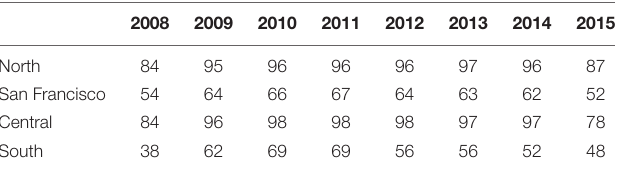
TABLE 1 | The percentage of traffic (i.e., the sum of the distance traveled per day in each grid cell) that occurs more than 24 nmi from the mainland coast (i.e., the boundary established by the California Air Resources Board as part of the clean fuel rule implemented on July 1, 2009) in each